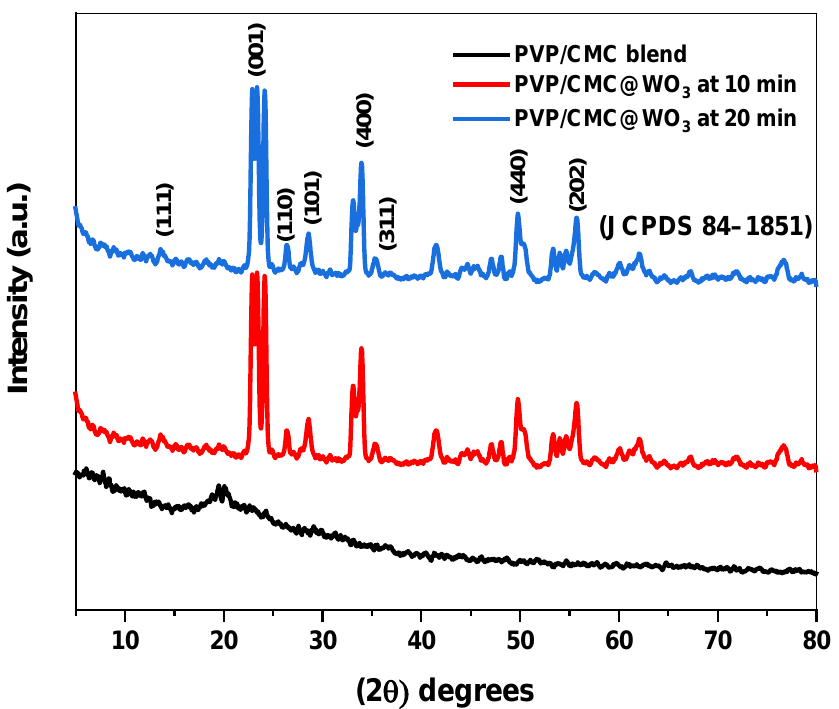
Figure 1. XRD pattern of polymer blend PVP/CMC and blend filled with WO 3 at 10 min and 20 min laser-ablation time.